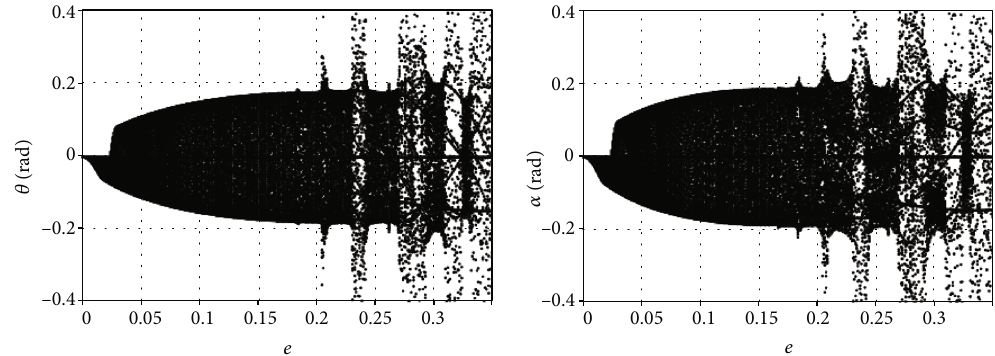
Figure 6: Bifurcation diagrams changing with orbital eccentricity e under superharmonic resonance.